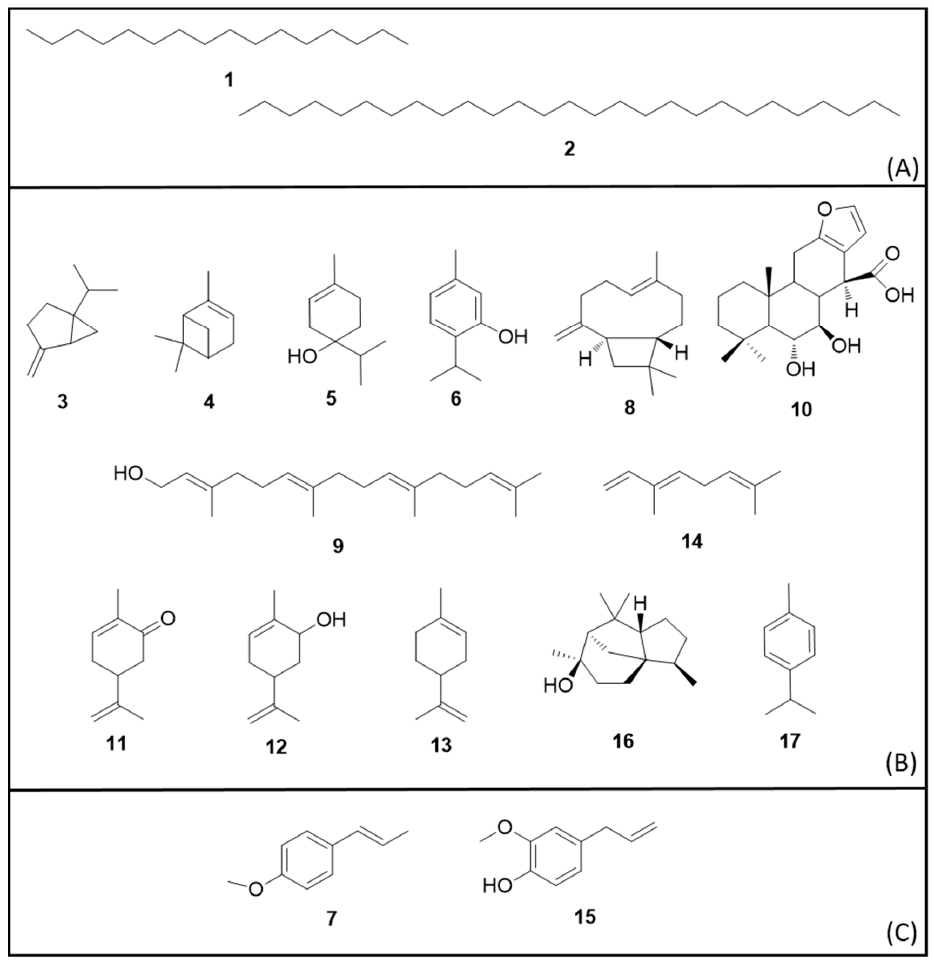
Figure 2. Essential oils to combat the Ae. aegypti mosquito: an ecologically safe alternative.